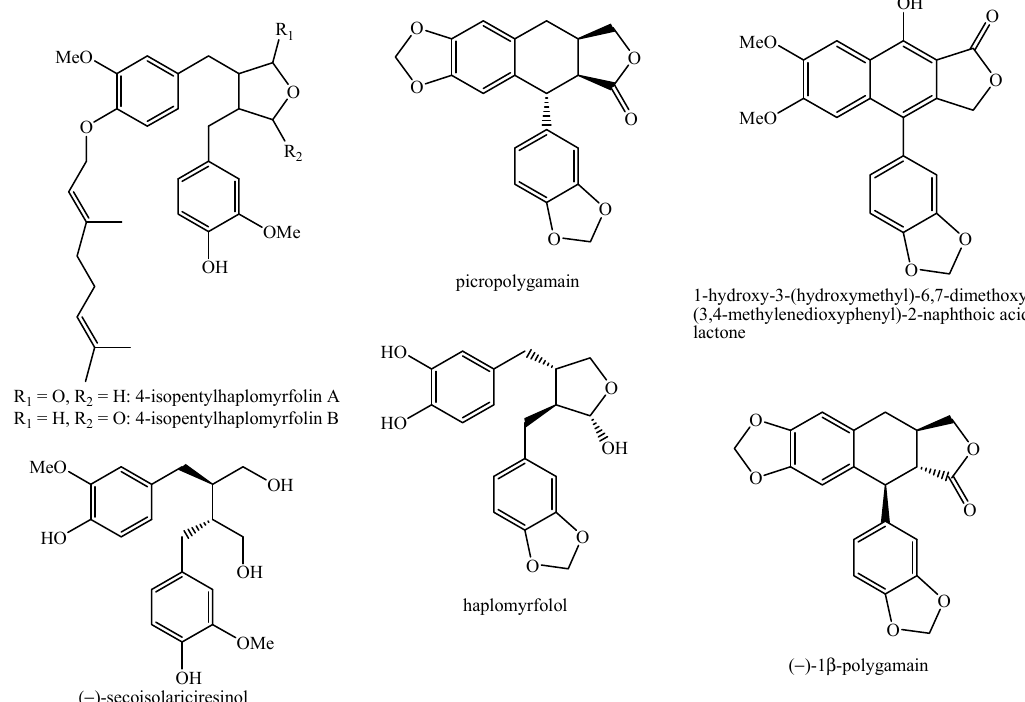
Figure 11. Structure of the lignans identified in Haplophyllum species—part 2.